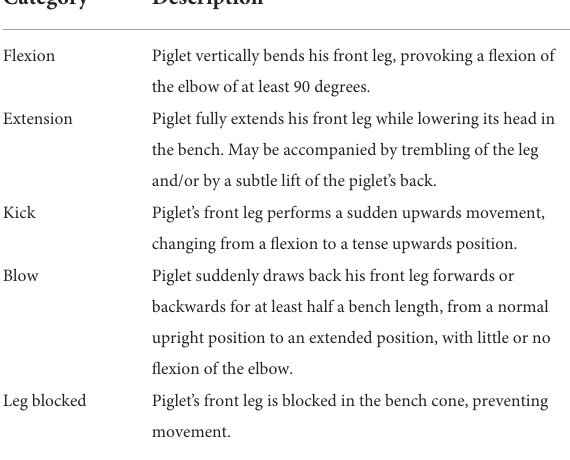
TABLE 3 Description of the foreleg movements recorded during injection of local anesthetic, castration, or sham handling while in the castration